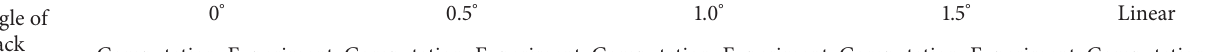
Table 2: Flutter speeds under different angles of